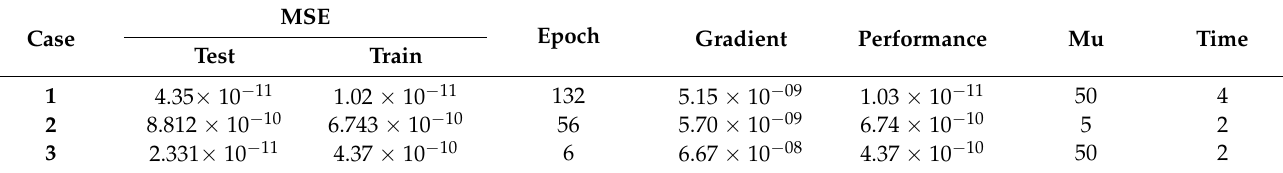
Table 2. ANNs procedures with the Bayesian regularization process to solve the dynamical